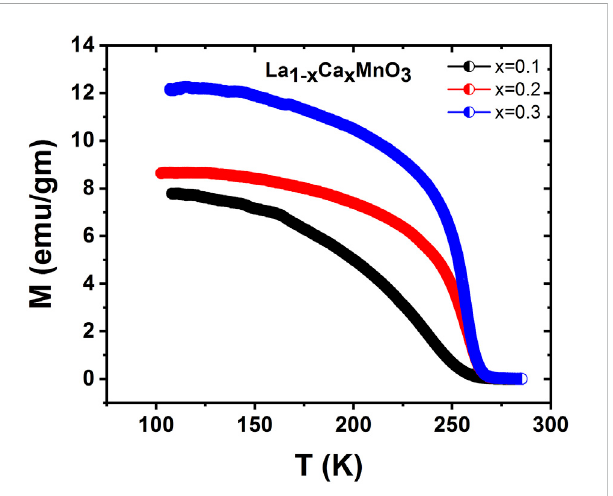
FIGURE 5 Magnetization as a function of temperature for La 1-x Ca x MnO 3 (x = 0.1, 0.2, and 0.3).